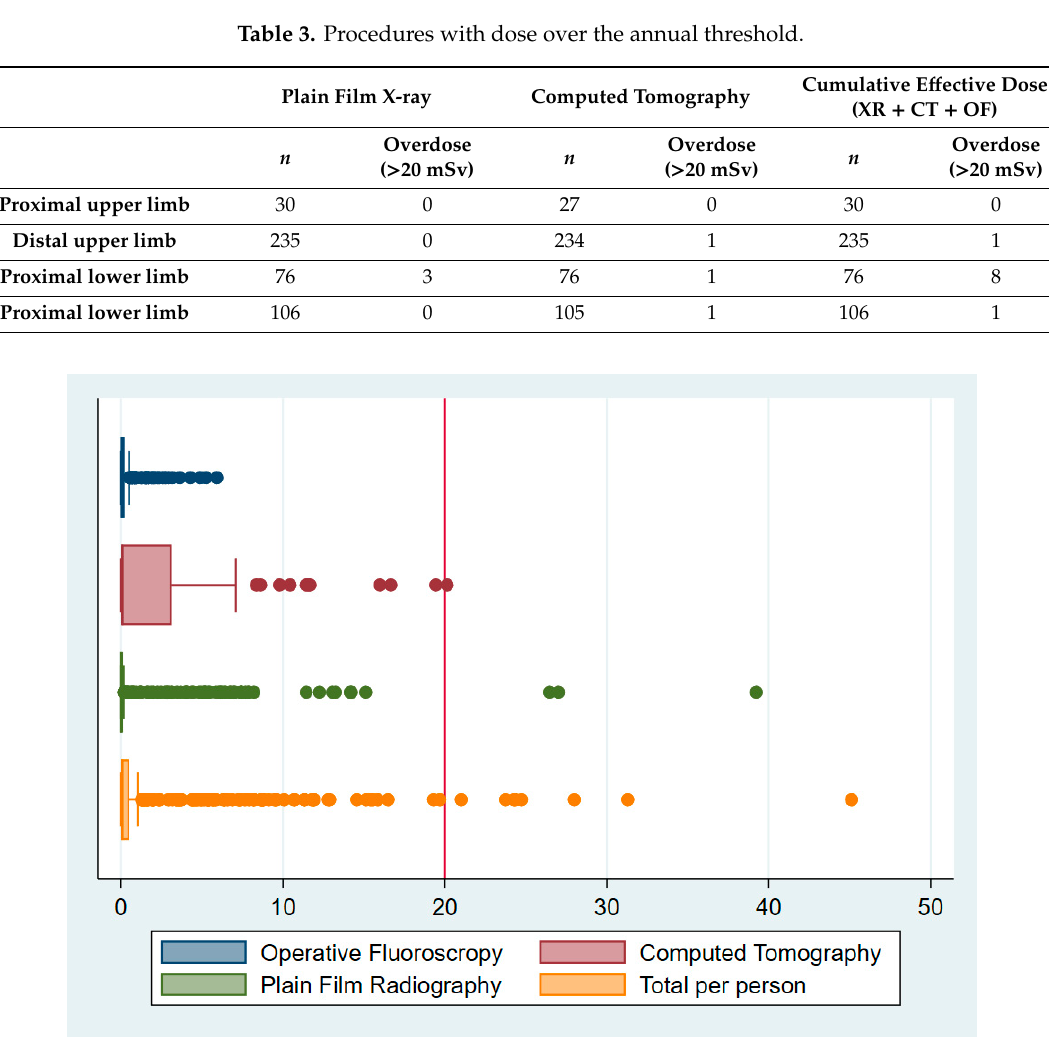
Table 3. Procedures with dose over the annual threshold.